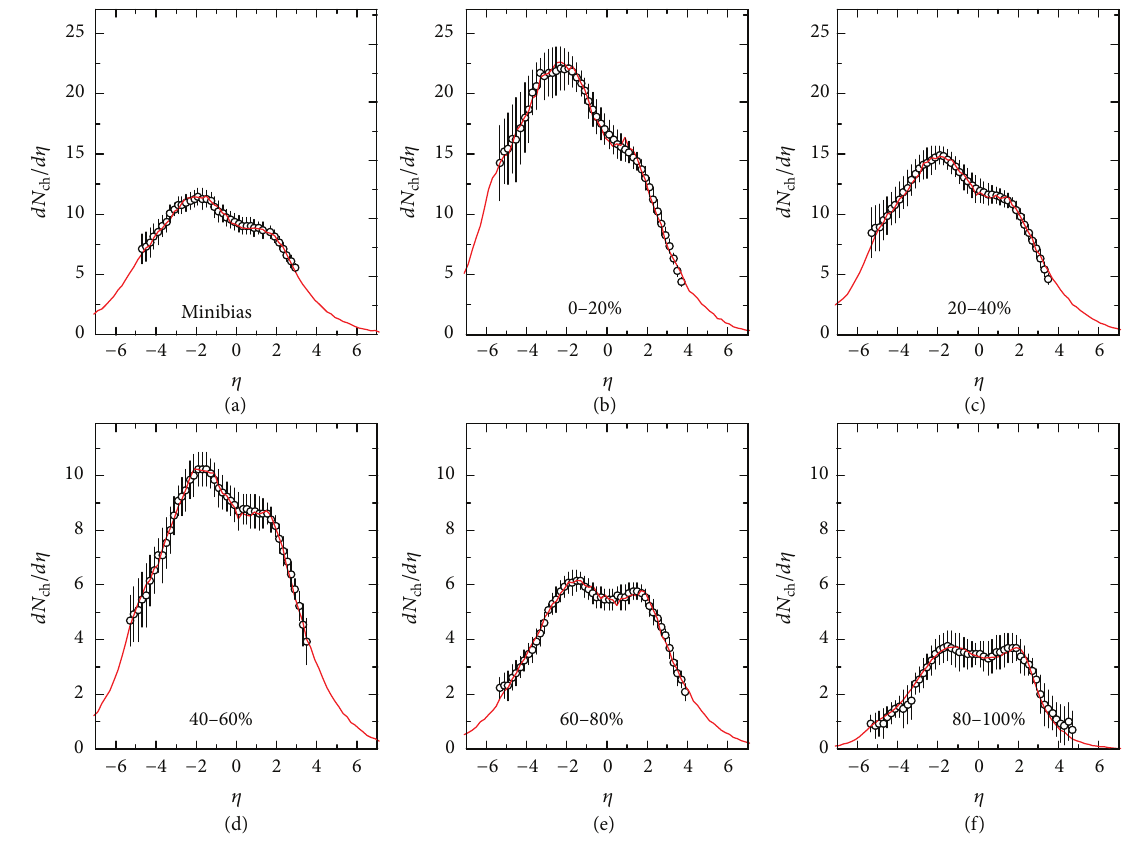
Figure 9: The same as Figure 1 but showing the results of 𝑑 -Au collisions at √𝑠 NN = 0.2 TeV, where the data are quoted in [23, 24] (Figure 9(a)) and [25] (Figures 9(b)–9(f)). Table 4: Values of peak positions ( 𝑦 𝑇 , 𝑦 𝑃 , and 𝑦 𝐶 ), contribution ratios ( 𝑘 𝑇 and 𝑘 𝑃 ), width 𝜎 , and 𝜒 2 / dof for the curves in Figure 9 which shows 𝑑 -Au collisions at 0.2 TeV for minimum-bias sample (Figure 9(a)) or with different centralities (Figures 9(b)–9(f)).